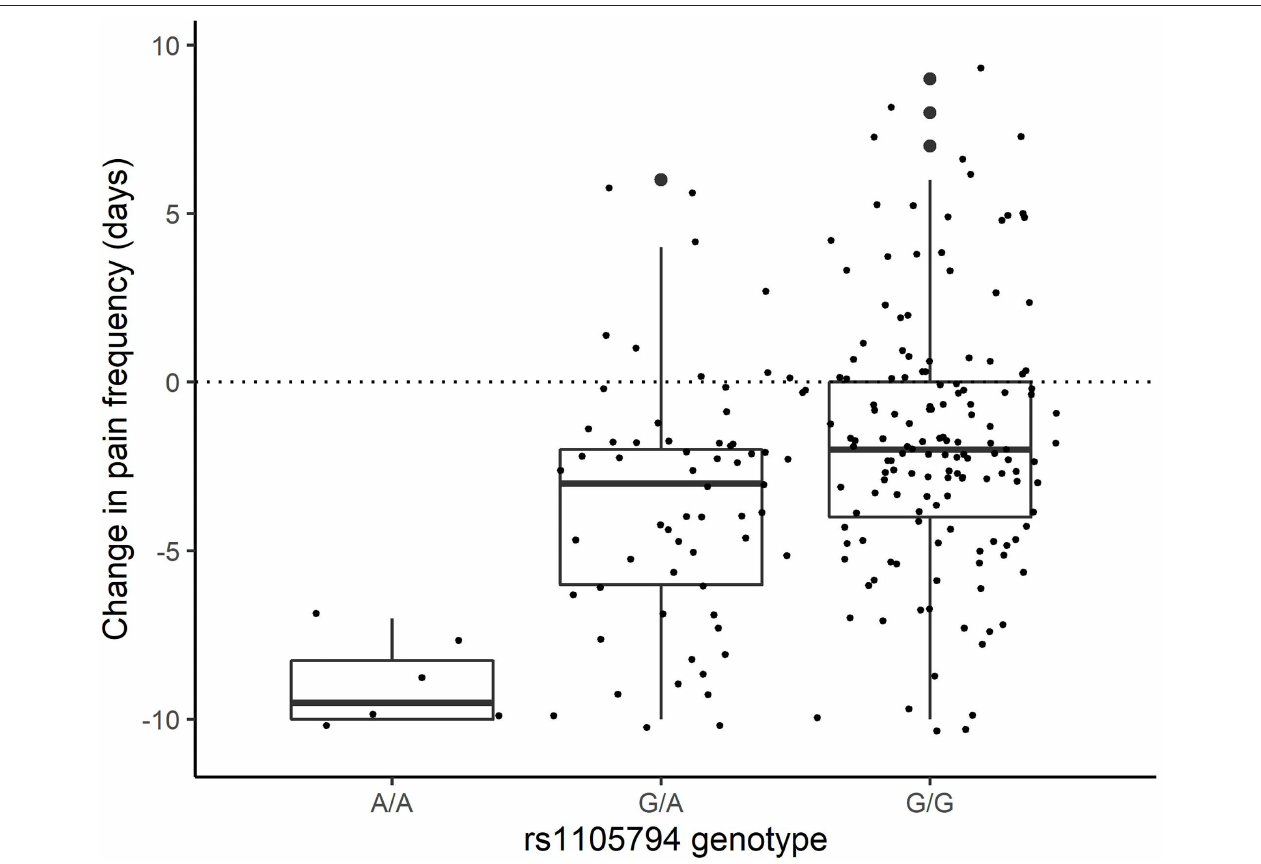
FIGURE 4 | Change in pain frequency by rs1105794 across three allele variants: met/met (A/A), val/met (G/A), val/val